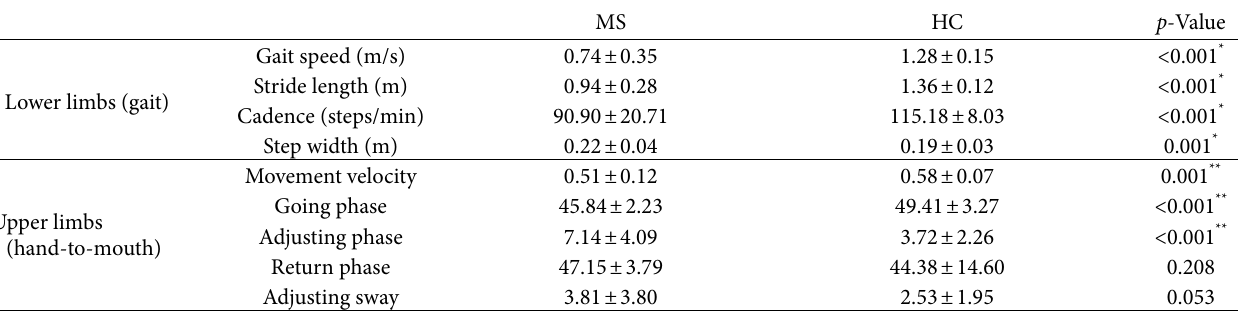
Table 2: Comparison between kinematic parameters of gait (top) and hand-to-mouth task (bottom) for people with multiple sclerosis (MS) and healthy controls (HC). Values are expressed as mean ± standard